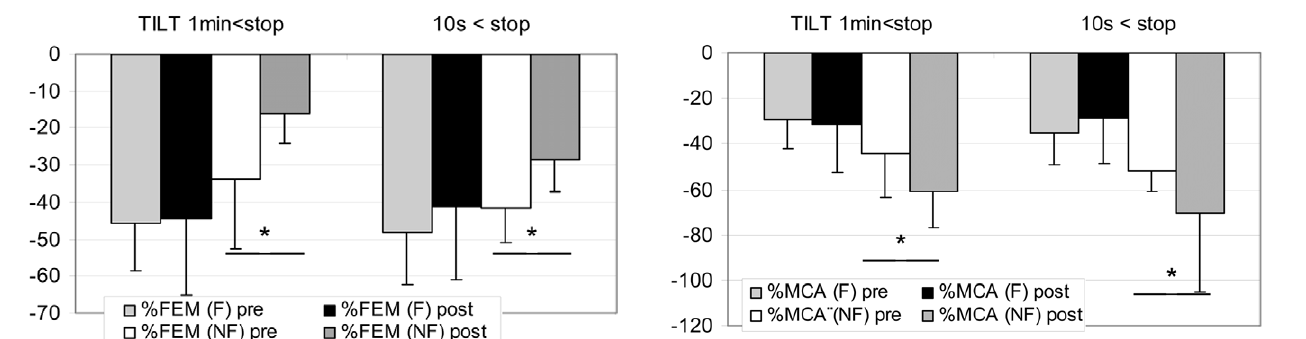
Figure 2. Percent decrease in FEM (femoral) flow at 1 min and 10 s before end of Tilt (from supine) in F (finisher n=17) and NF (non finisher n=4). Similar change pre/post HDBR at 1 min and 10 s. (mean + / 2 SD, * P , 0.05).